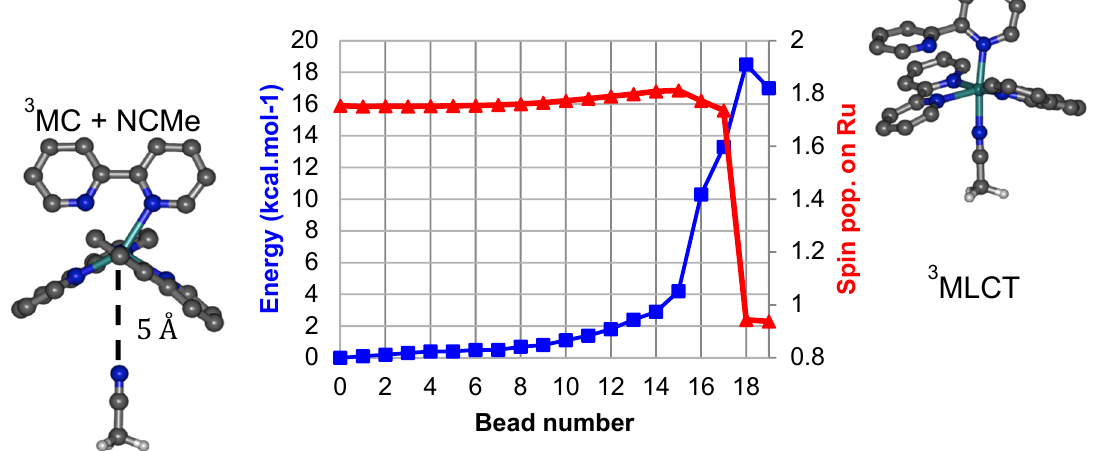
Figure 2. Minimum energy path (blue) and Mulliken spin population on Ru (red) for the coordination of acetonitrile on the 3 MC state from Nudged Elastic Band calculations.